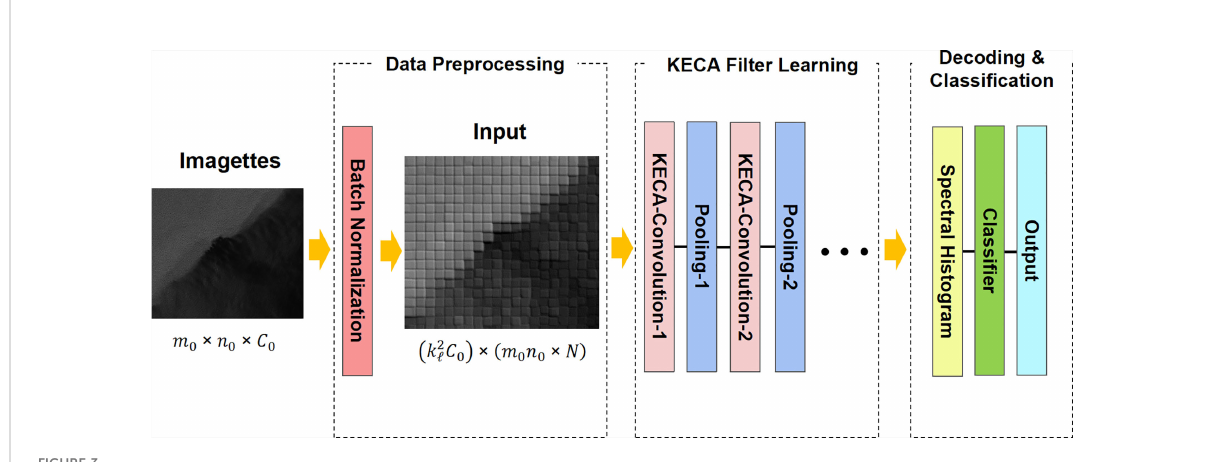
FIGURE 3 The work fl ow of ocean SAR scene classi fi cation using KECANet.